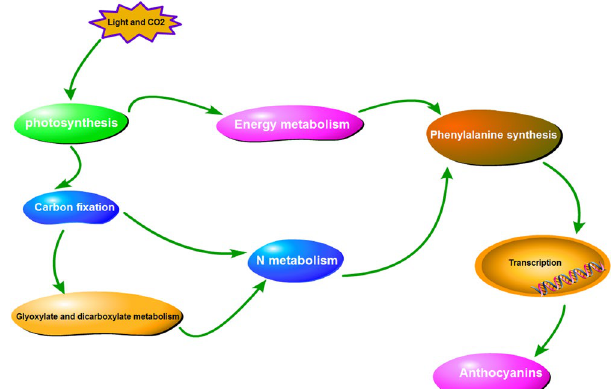
Figure 7. The key metabolic pathway in ‘Tianyuanhong’ during the stage of fruit color